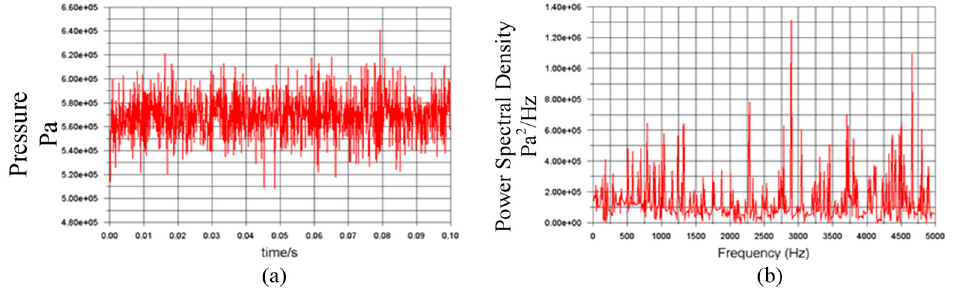
Figure 12. Pressure oscillation curve of the flapper when the displacement of the flapper is x = 0.00 mm. ( a ) Point 1 in the time domain. ( b ) Point 1 in the frequency domain.